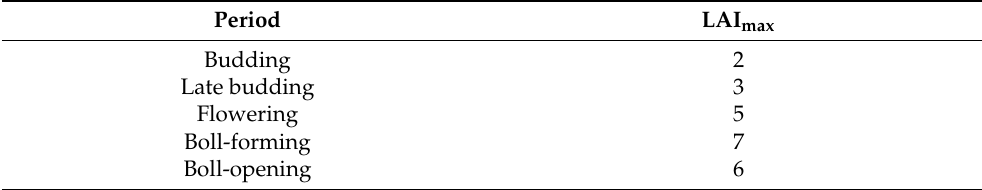
Table 3. Thresholds limit at various periods of cotton used for model correction in this study. Period LAI max Budding 2 Late budding 3 Flowering